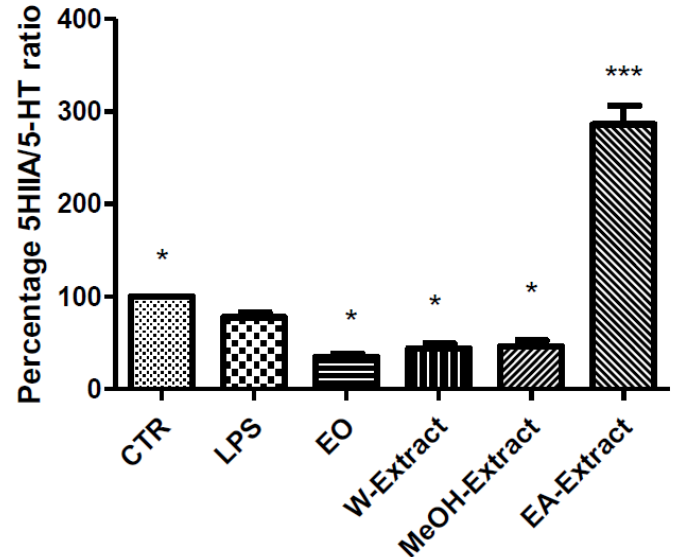
Figure 4. E ff ect of essential oil (EO) and water (W), methanol (MeOH) and ethyl acetate (EA) A. santonicum extracts (100 µ g / mL) on LPS-induced reduction of 5-HT turnover (5HIIA / 5-HT ratio) in rat colon specimens. Only EA extract was able to increase the level of nitrites observed in both control (CTR) and LPS groups. p < 0.0001; post-hoc, * p < 0.05, *** p < 0.001 vs. LPS.